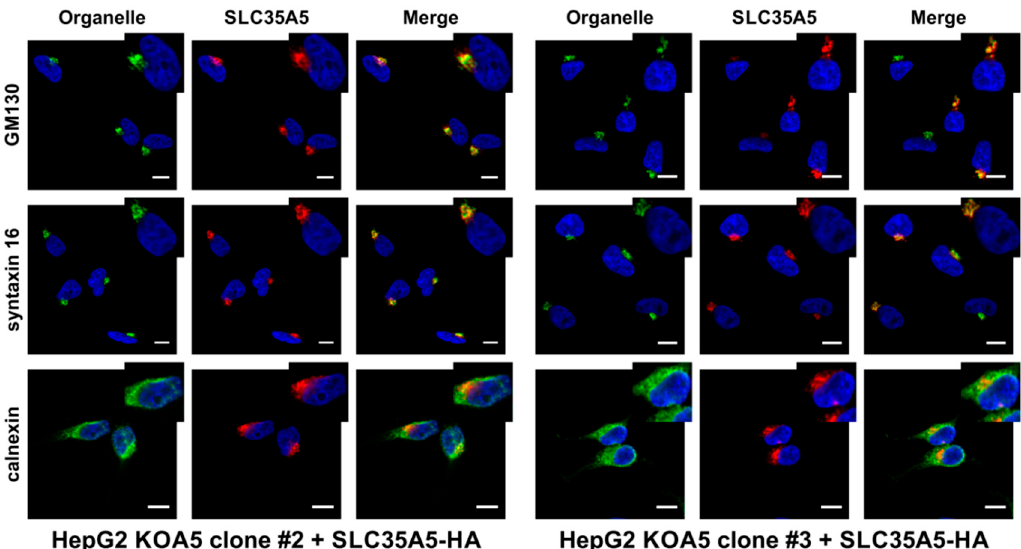
Figure 6. Subcellular localization of SLC35A5 protein. Subcellular localization of SLC35A5 protein was determined in HepG2 SLC35A5 knock-out cells (clone #2 and #3) stably overexpressing SLC35A5/hemagglutinin (HA). Recombinant SLC35A5 was visualized using mouse anti-HA-Alexa Fluor 647 antibody (red), whilst Golgi and endoplasmic reticulum (ER) were counterstained with specific rabbit antibodies (green). Cell nuclei were counterstained with 4 ′ ,6-diamidino-2-phenylindole (DAPI). Scale bar = 10 µm.